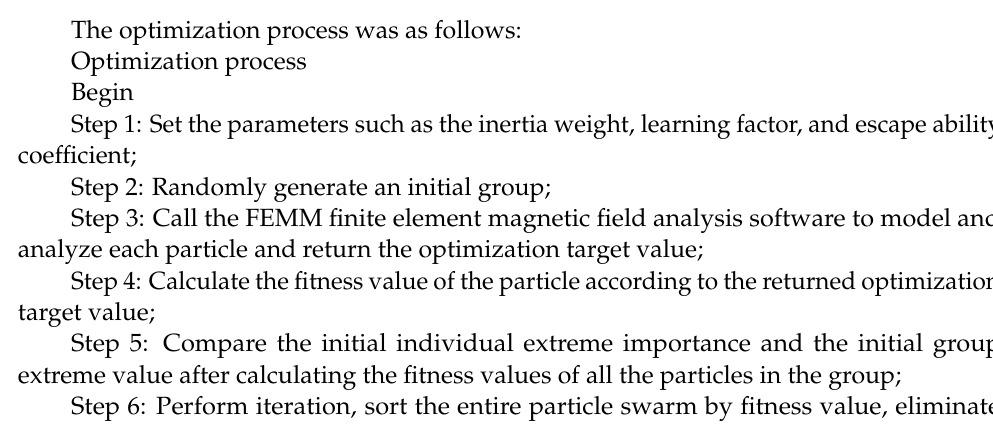
Figure 13. Block diagram of the stepped rotor BLSRM optimization design system.